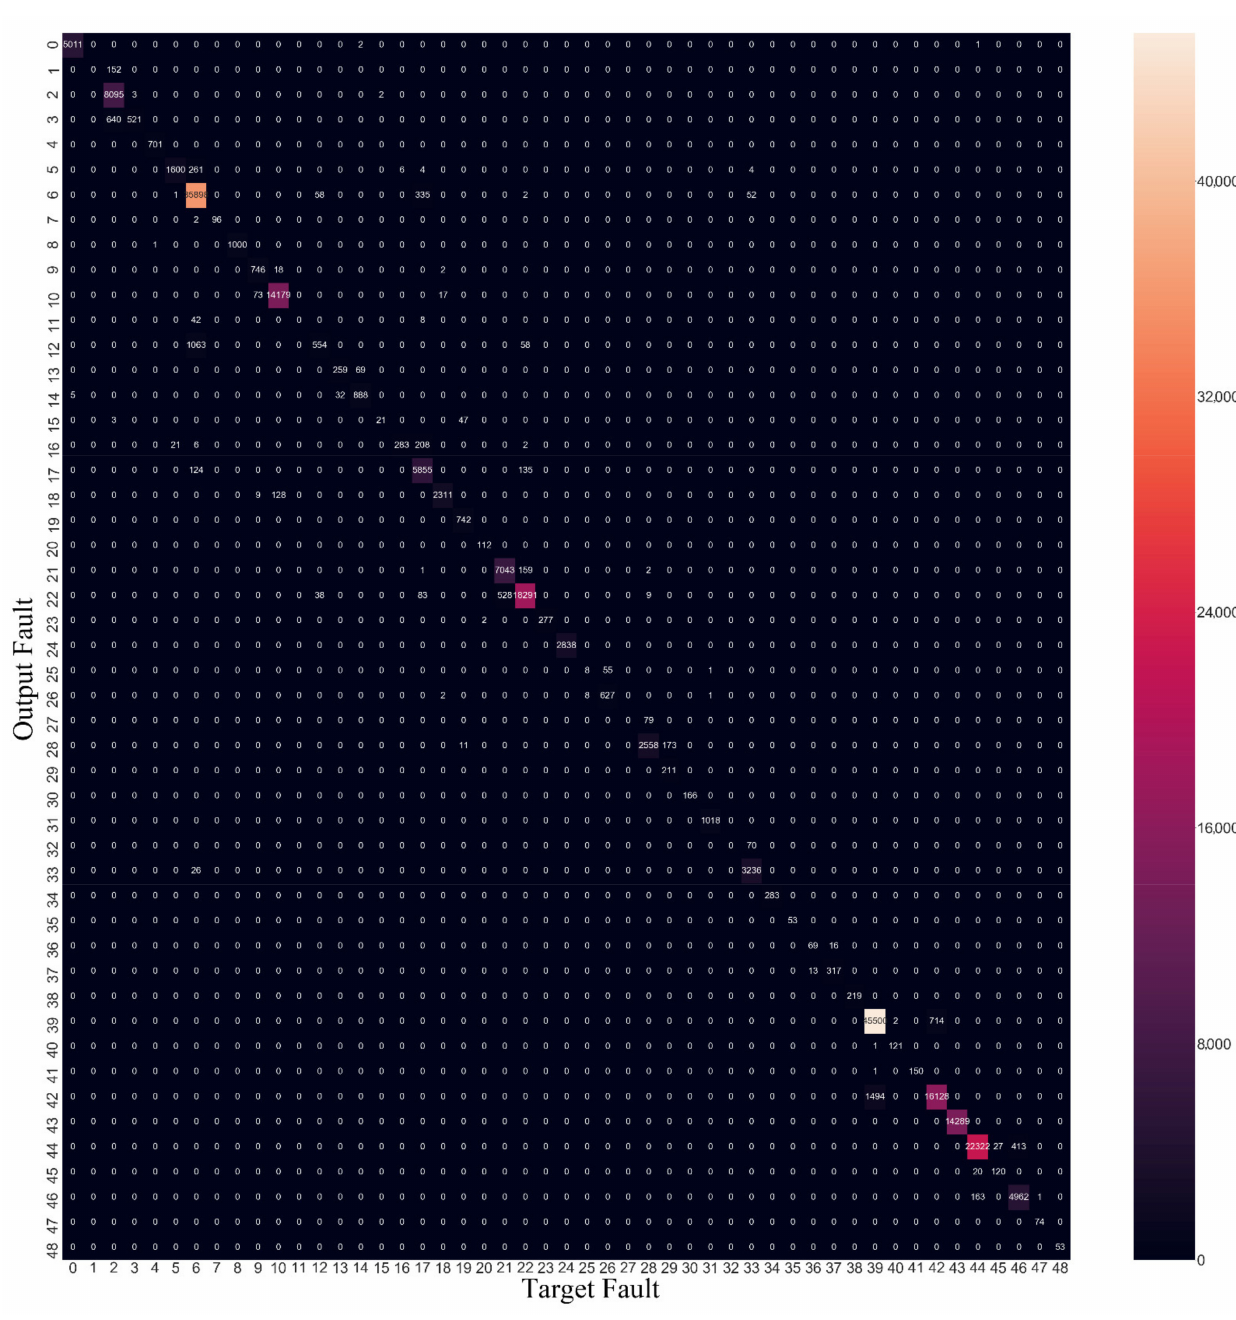
Figure 10. Confusion matrix of modified